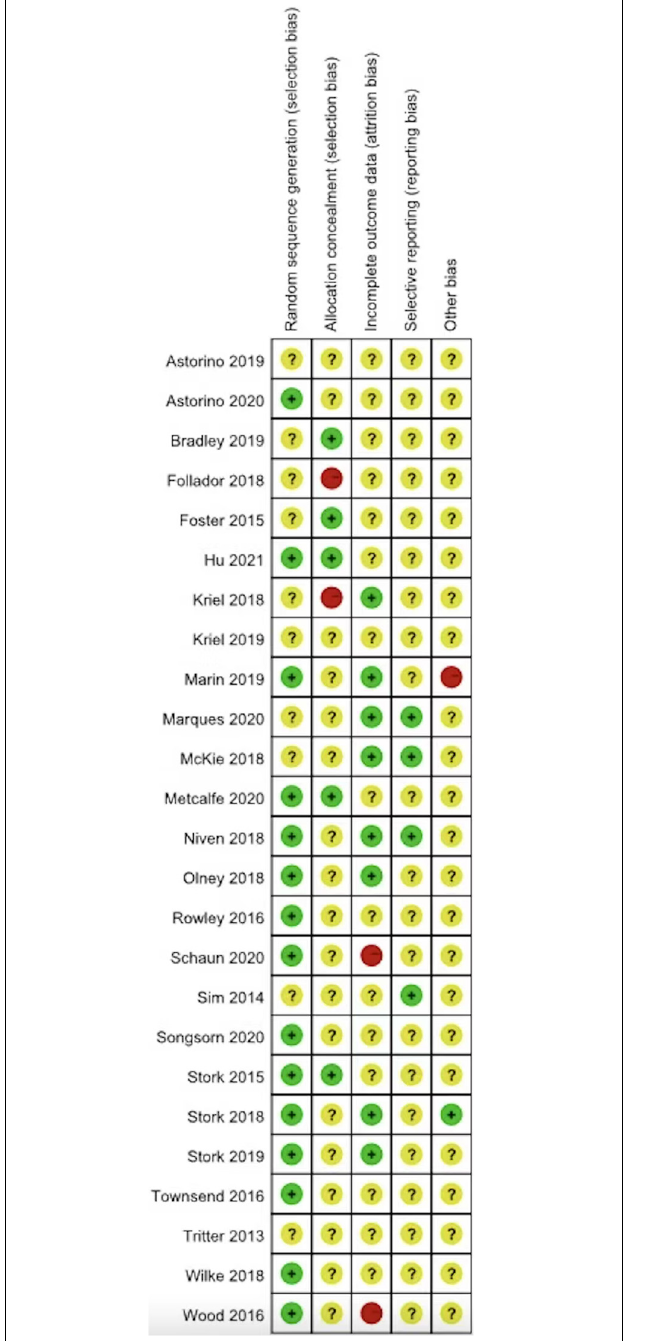
were not included for the assessment as the studies in the current review could not possibly meet these criteria due to the nature of study protocols. A visual analysis of the created funnel plot was performed to identify publication bias based on evidence of asymmetry. Heterogeneity was calculated using I 2 tests